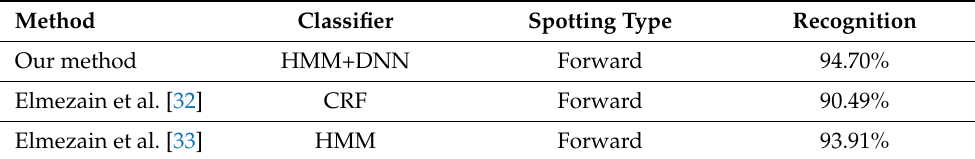
Table 3. A comparison between our method and our previous work for the same dataset.